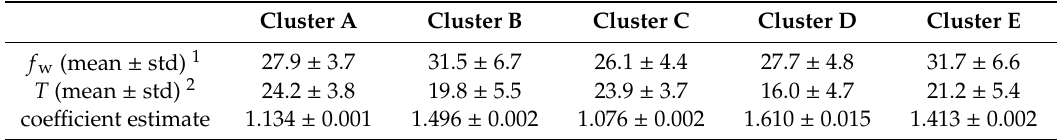
Table 3. Means and standard deviations of wingbeat frequency ( f w ) and air temperature ( T ) for each cluster and coe ffi cient of linear regression of the f w on T for each cluster.